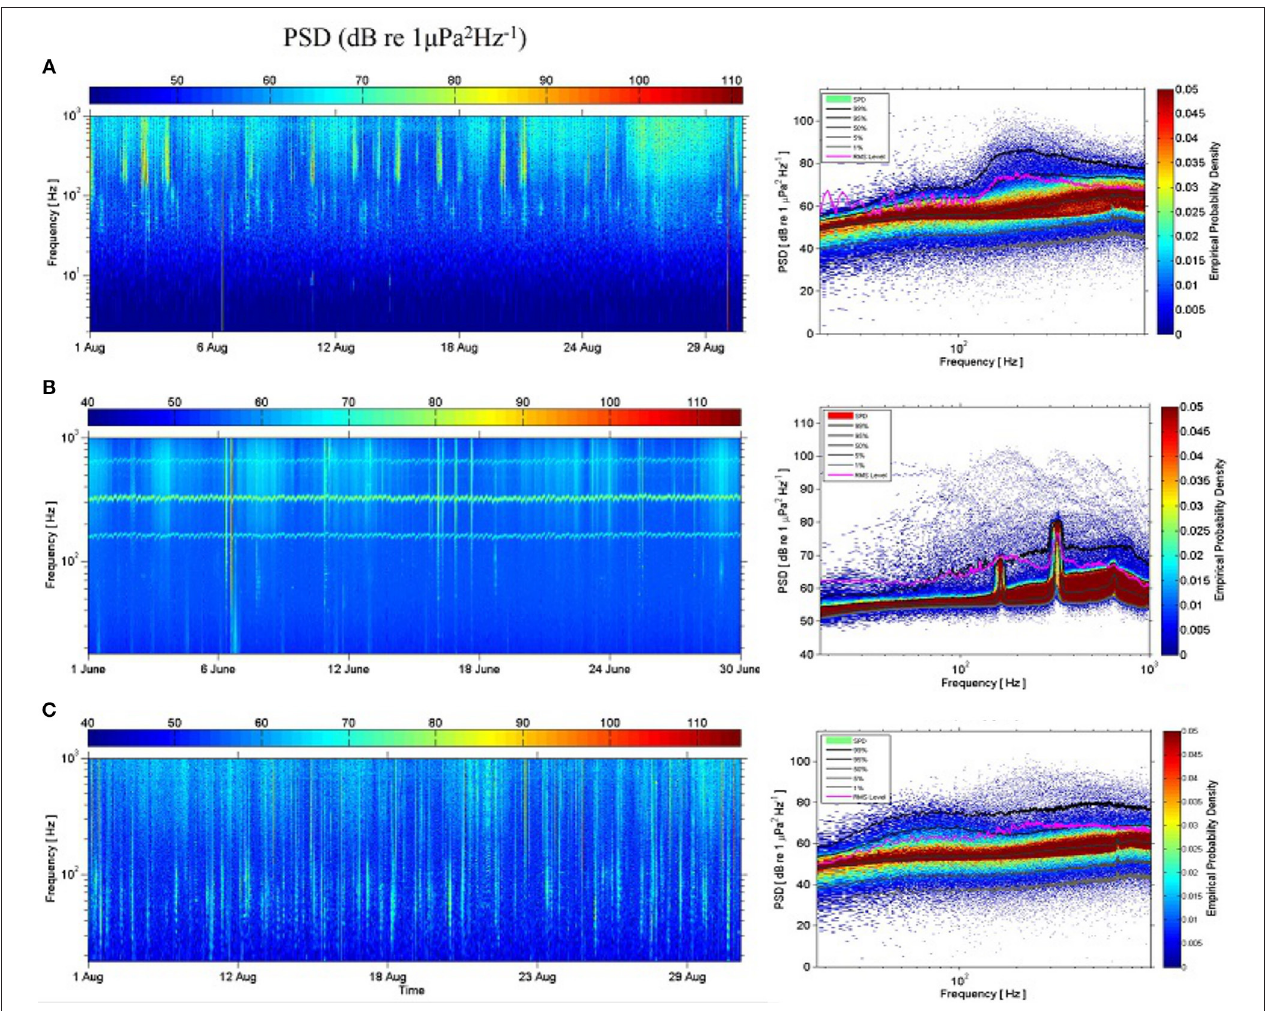
FIGURE 4 | Spectrograms composed of PSDs with 1-s time segments (left) and spectral probability densities (SPDs), percentiles and root-mean-square (RMS) level (right) of 1 month of recordings for (A) Condor; (B) Açores; and (C)